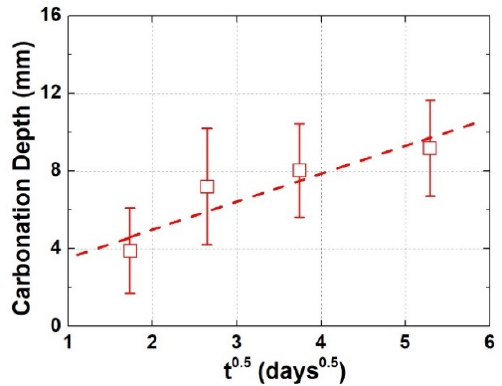
Figure 5. Carbonation depth as a function of the carbonation age.